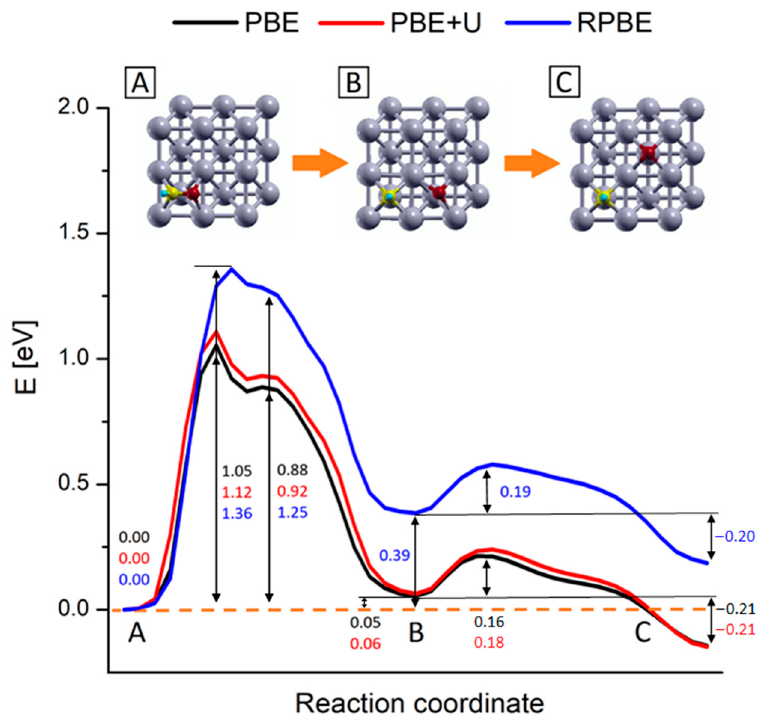
Figure 6. Reaction energy profiles for the CHO* → CH* + O* reaction on Rh (100) surface. Black, red and blue lines represent the profiles calculated at the PBE, PBE+U and RPBE levels respectively. The numbers report the values of energy barriers and reaction energies in eV. Inset pics represent the geometries of the main steps of the process: (A) CHO* most stable configuration, (B) configuration of dissociated species and (C) equilibrium configuration of the dissociated species upon oxygen diffusion. Yellow, red, light blue and grey represent C, O, H and Rh atoms respectively.